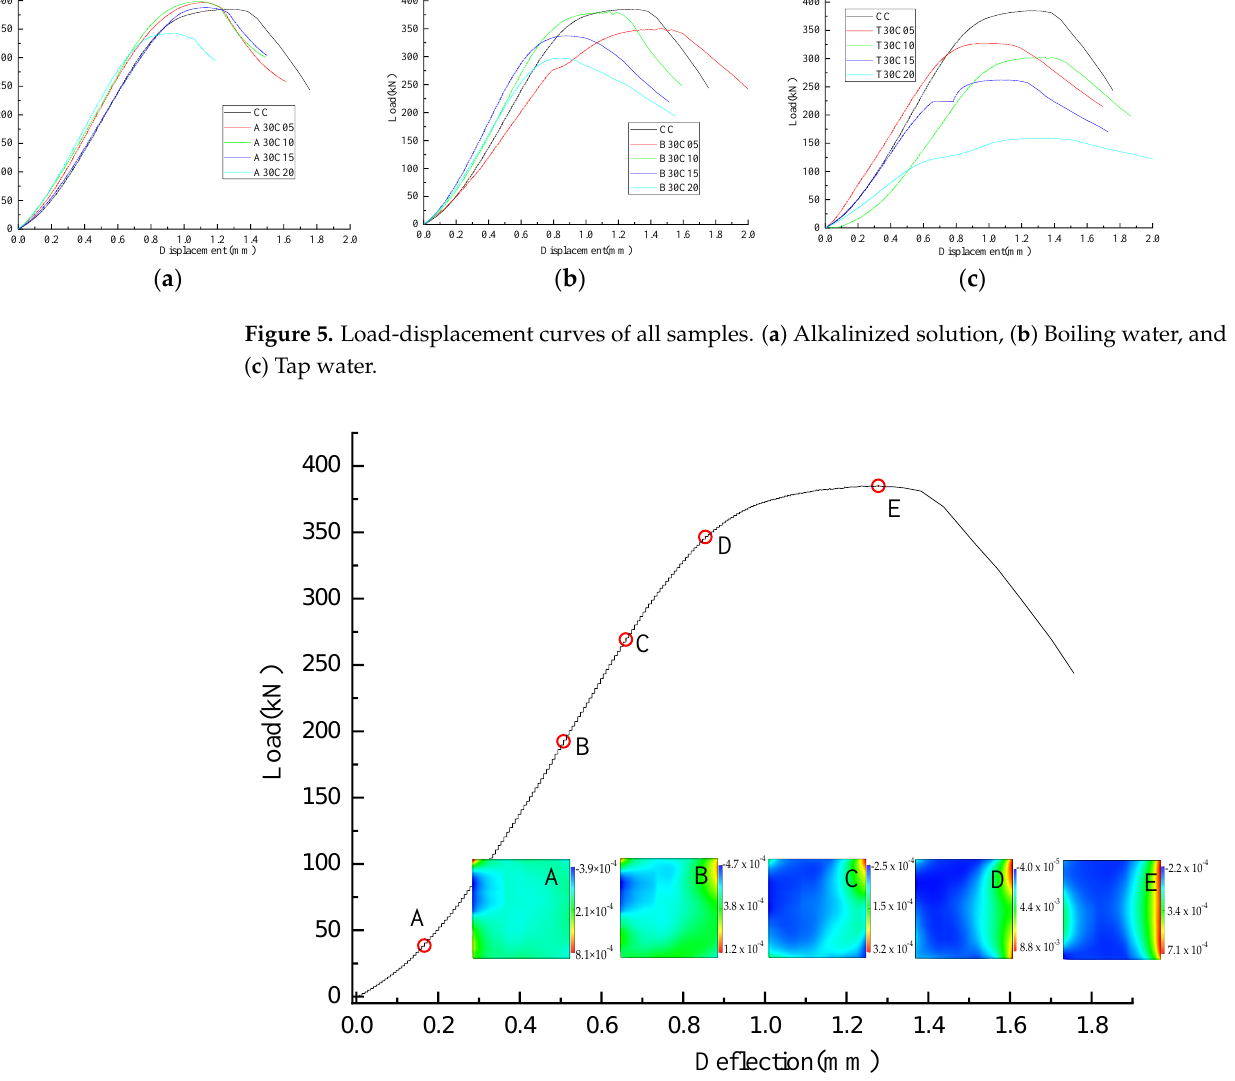
Figure 6. The load-displacement curve and horizontal strain field of ordinary concrete (CC) sample. At the early phase of loading (before A), the coordinated deformation of the corner part of the specimen and the indenter resulted in local breakage, causing a weak strain concentration. In the early loading stage A–C, the strain field of the CC sample is relatively uniform, as the samples are in the linear stage of the load-displacement curve under compression. However, the strain fields on the surface of the PNFRC specimen present an uneven shape. At the elastic stage, the relative deformation fields of PNFRC were formed, and fiber and concrete bear forces